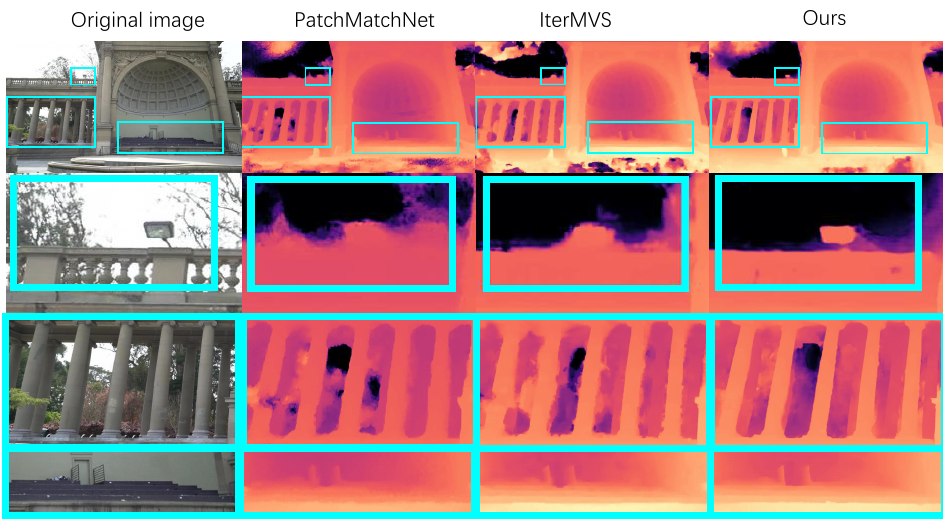
Figure 7. Depth estimation of Temple on Tanks and Temples